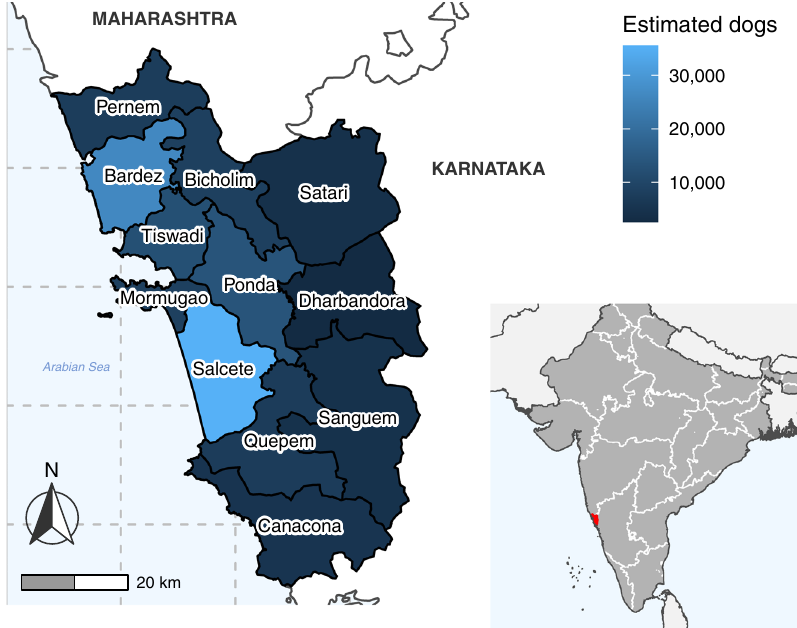
Fig. 1 Map of Goa state estimated dog population by taluka. Choropleth map of Goa state showing taluka boundaries and colored by the estimated dog population. Dog population estimates were calculated from mean vaccination coverage and mean number of dogs vaccinated per taluka during vaccination cycles in which comprehensive post-vaccination surveys took place (Supplementary Methods, Supplementary Fig. 7). Inset map shows the state borders of